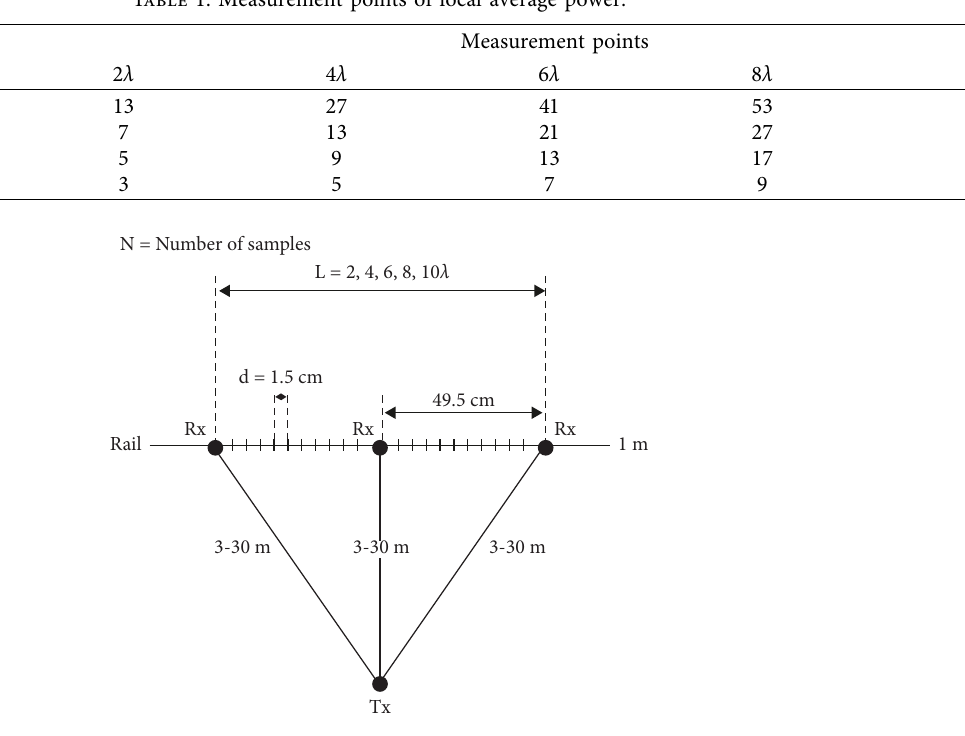
Figure 2: Rail of the local average power measurement. (a) Schematic. (b) Prototype.